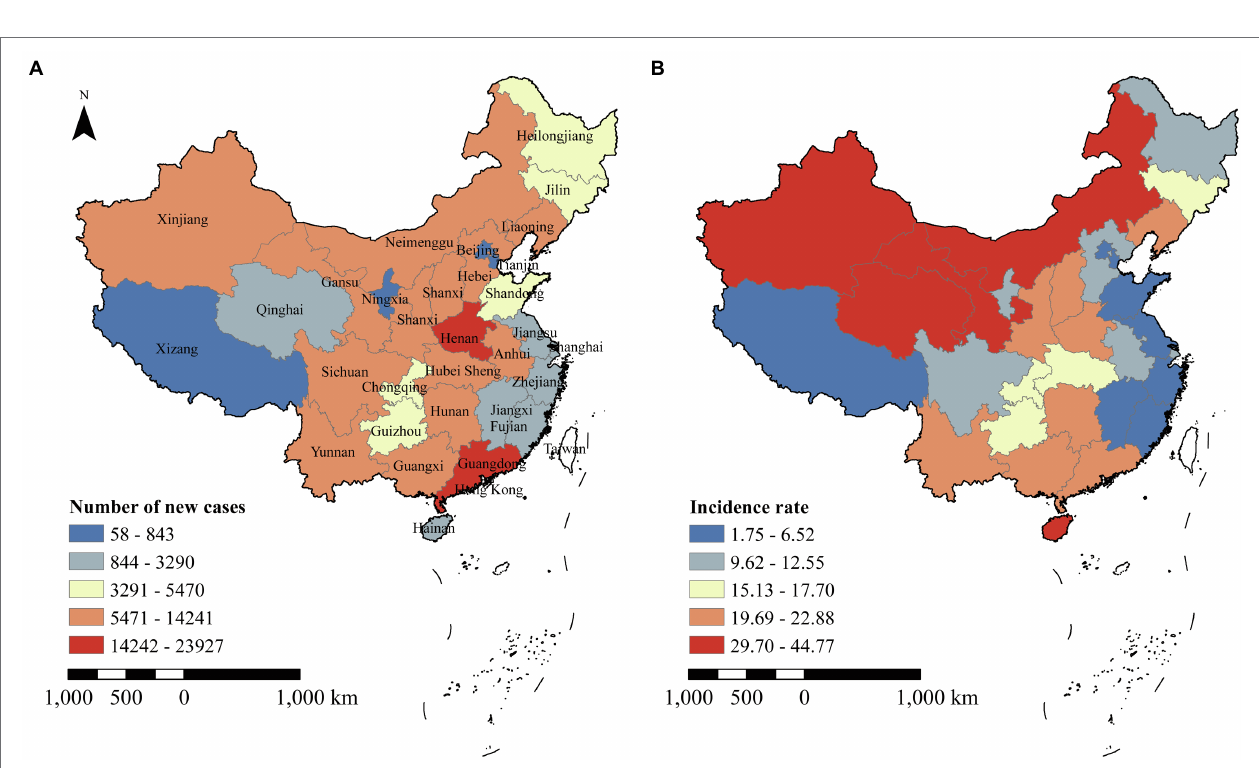
FIGURE 1 | Monthly reported number of new cases, deaths, incidence, and death rates of hepatitis C in China, 2005–2017. Orange line in plot (A) used left axis represents new cases, and blue line used left axis represents death cases of hepatitis C virus (HCV) per month reported by Chinese Centre for Disease Control and Prevention (CDC). Plot (B) is the rate calculated by new cases and death cases in plot (A) after adjusting for population.